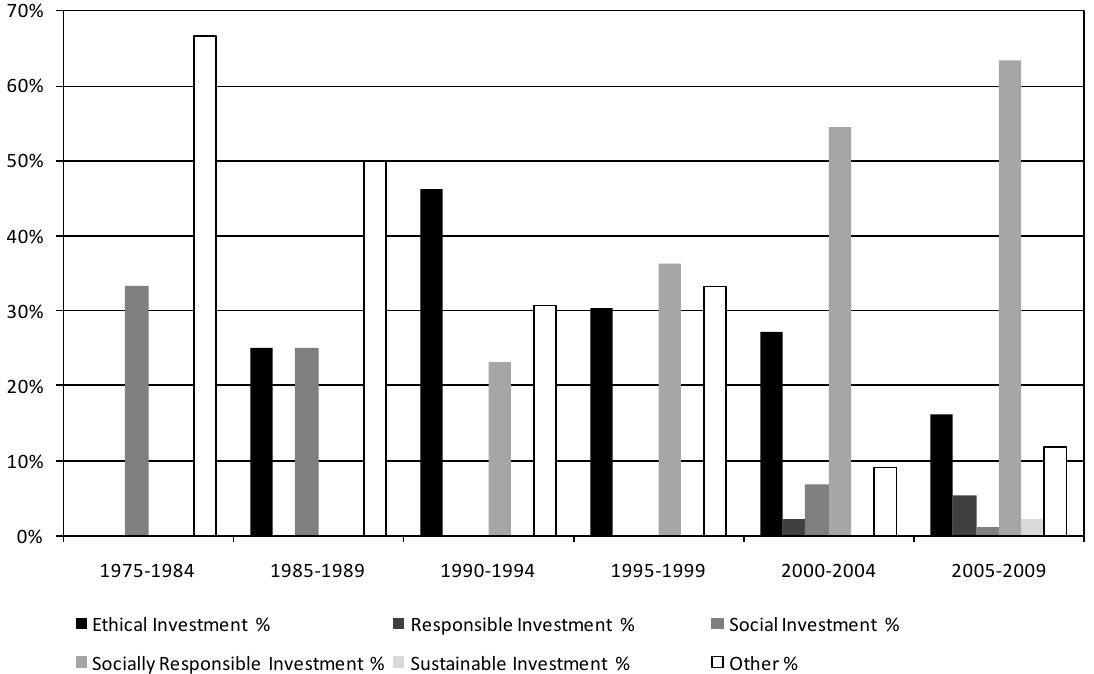
Figure 3: Frequency of the occurrence of names for investment practices that integrate a consideration of ESG issues Table 4: Research